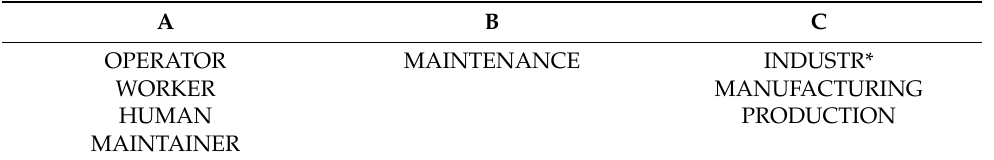
Table 1. Groups of keywords.